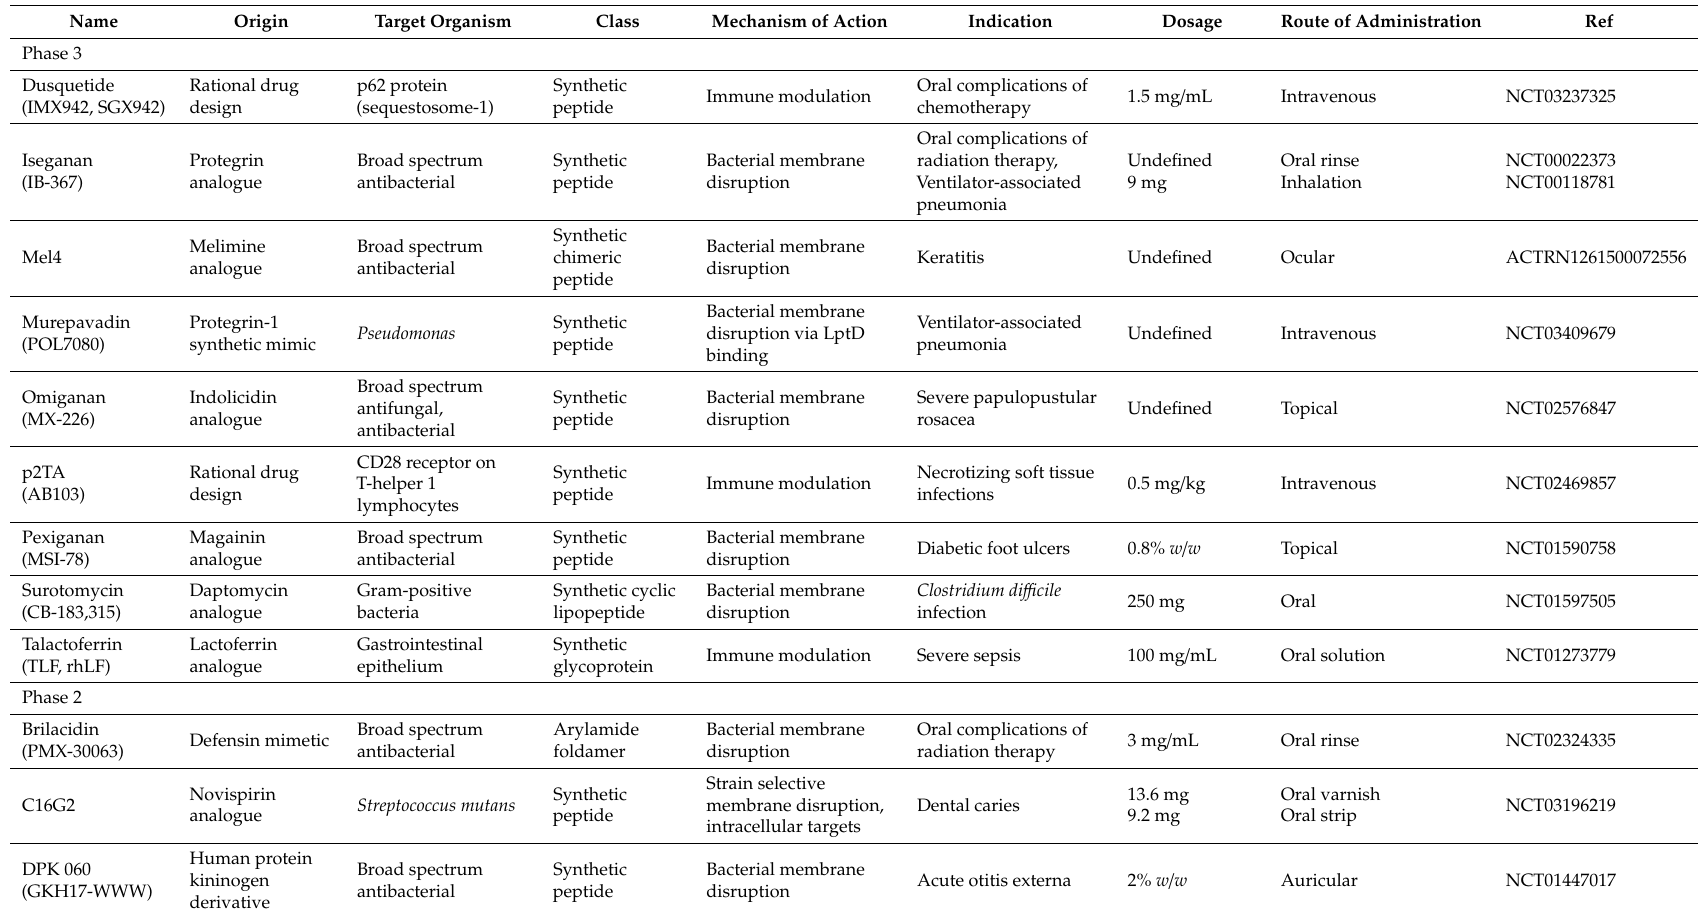
Table 2. Peptide-based antimicrobial compounds in clinical